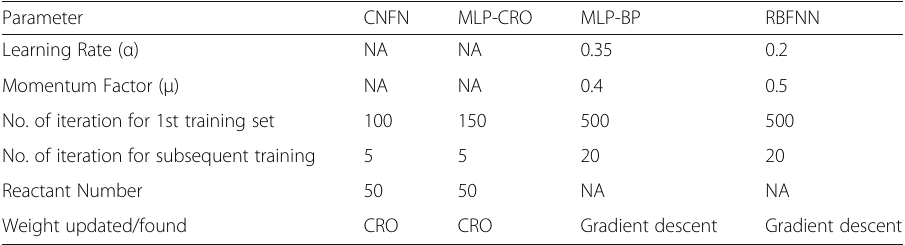
Table 6 Simulated parameters for the forecasting